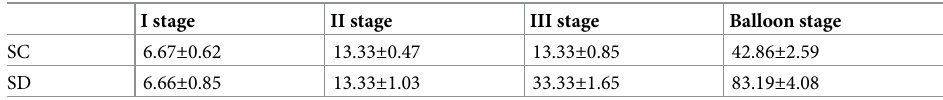
Table 1. The pistil abortion rate at different stages of flower buds